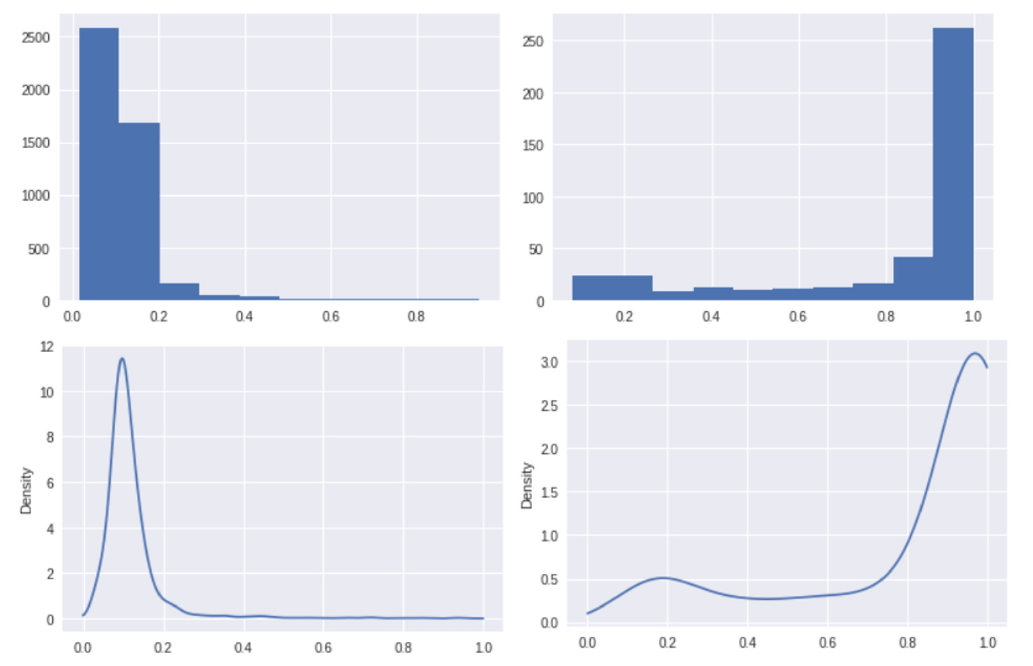
Figure 6. Histograms ( top ) and PDFs ( bottom ) for Non-Defect class ( left ) and Defect class ( right